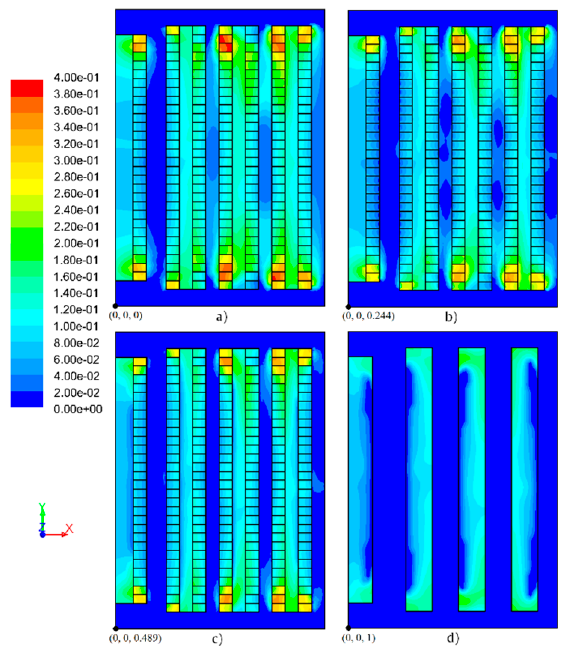
Figure 18. The results of the field of temperature in the x–y plane through the planes: ( a ) z adm = 0; ( b ) z adm = 0.244; ( c ) z adm = 0.489; and ( d ) z adm = 1.